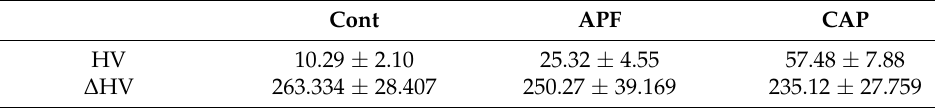
Figure 3. Vickers hardness measurements. ( A ) Graph of Vickers hardness (HV) values after acid challenge ( n = 5) (* p < 0.01); ( B ) Graph of Δ HV values (difference in the HV values between the challenge ( n = 5) (* p < 0.01); ( B ) Graph of ∆ HV values (difference in the HV values between the reference and experimental surfaces) values. reference and experimental surfaces) values. Table 1. Results of the measurement of HV and ∆ HV